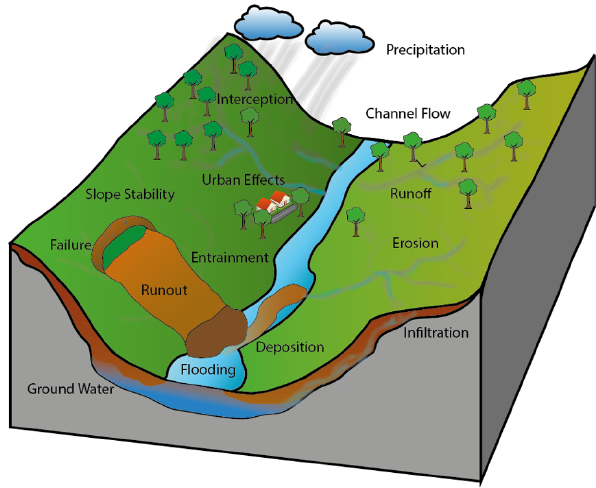
Figure 1. A schematic overview of processes, fluxes, and storage within the OpenLISEM